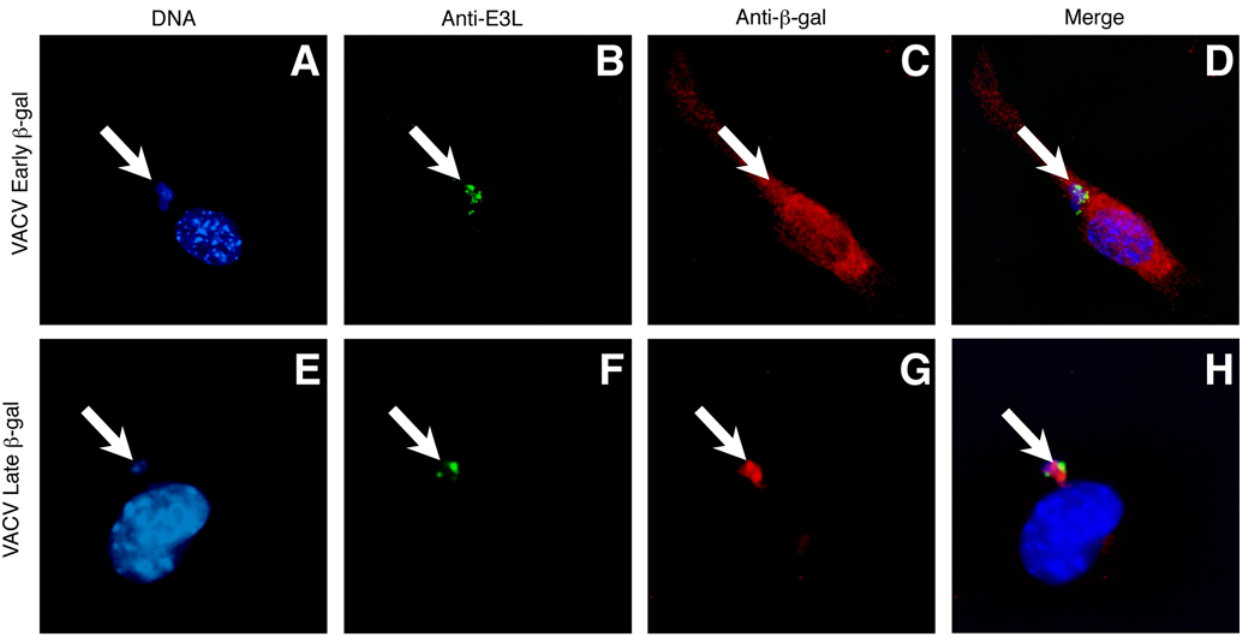
Figure 6. Late antigen that is not available for cross priming is sequestered in VACV viral factories. TAg- b 2 m neg cells were infected with rVACV- b -gal-Early (A–D) or rVACV- b -gal-Late (E–H) for 5 h and stained with antibodies to the VACV protein E3L (B,D,F,H) and b -gal (C,D,G,H). All cells were incubated with the nuclear counterstain DAPI (A,D,E,H). The white arrows indicate the location of viral factories in infected cells.